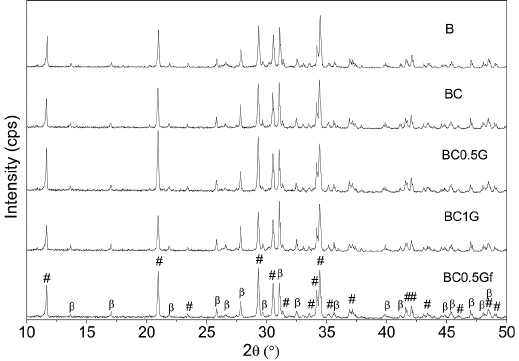
Figure 3. Powder X-ray diffraction patterns of cement and scaffold samples. Legend = β : β -TCP, #: